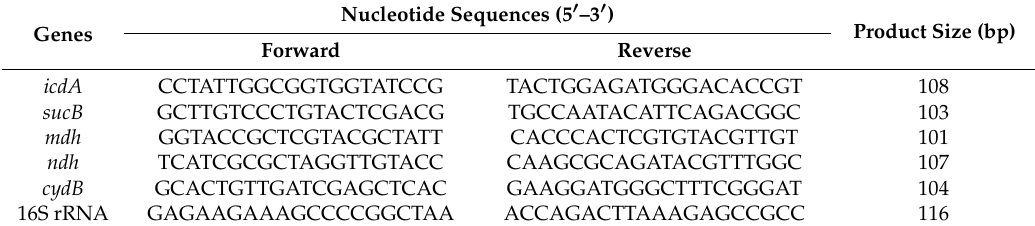
Table 4. Primers in quantitative real-time PCR for P.